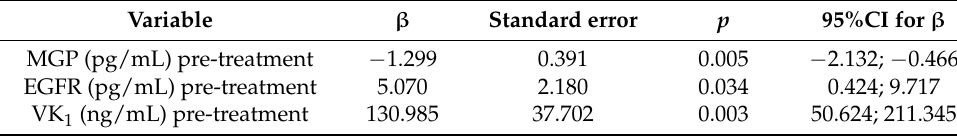
Table 5. Multivariate linear regression for MGP post-treatment values.